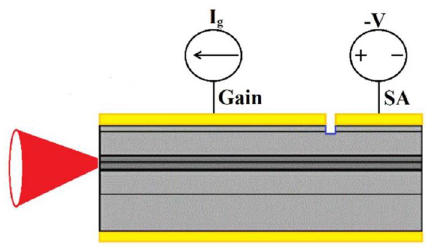
Figure 1. Sketch (side view) of the two-section MLL.